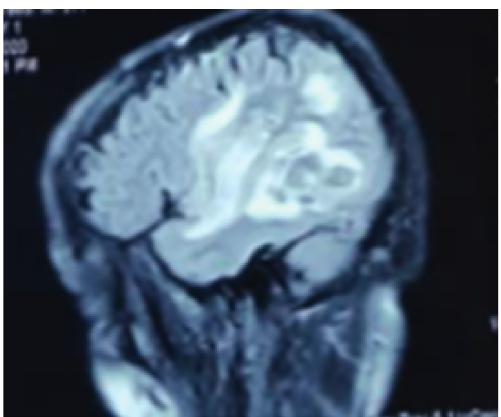
Figure 4: Brain MRI (FLAIR) in the sagittal plane showing hyperintensity in the right temporal